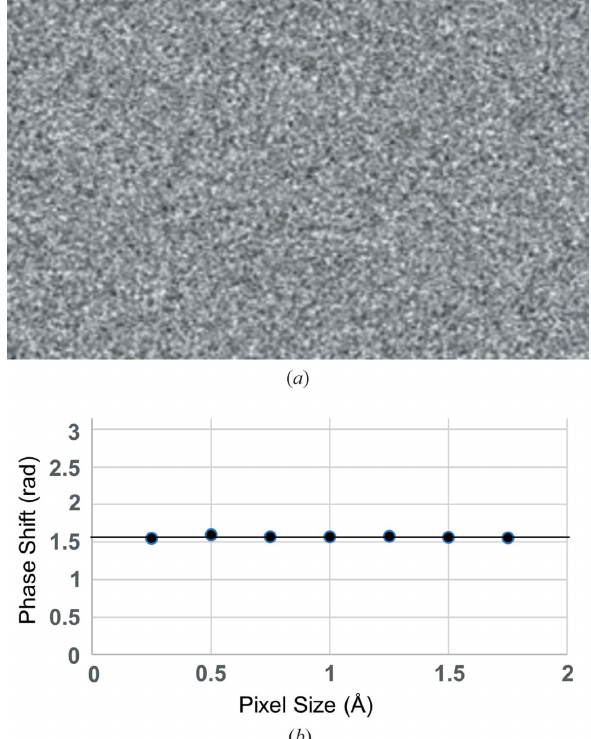
Figure 2 ( a ) Phase plate simulated from an amorphous layer of carbon atoms 348.6 A˚ thick with a density of 1.75 g cm (cid:2) 3 . ( b ) Mean phase shift for the simulated phase plate as a function of pixel sampling rate during simulation. Black line plotted at (cid:6) /2 radians for visual reference.